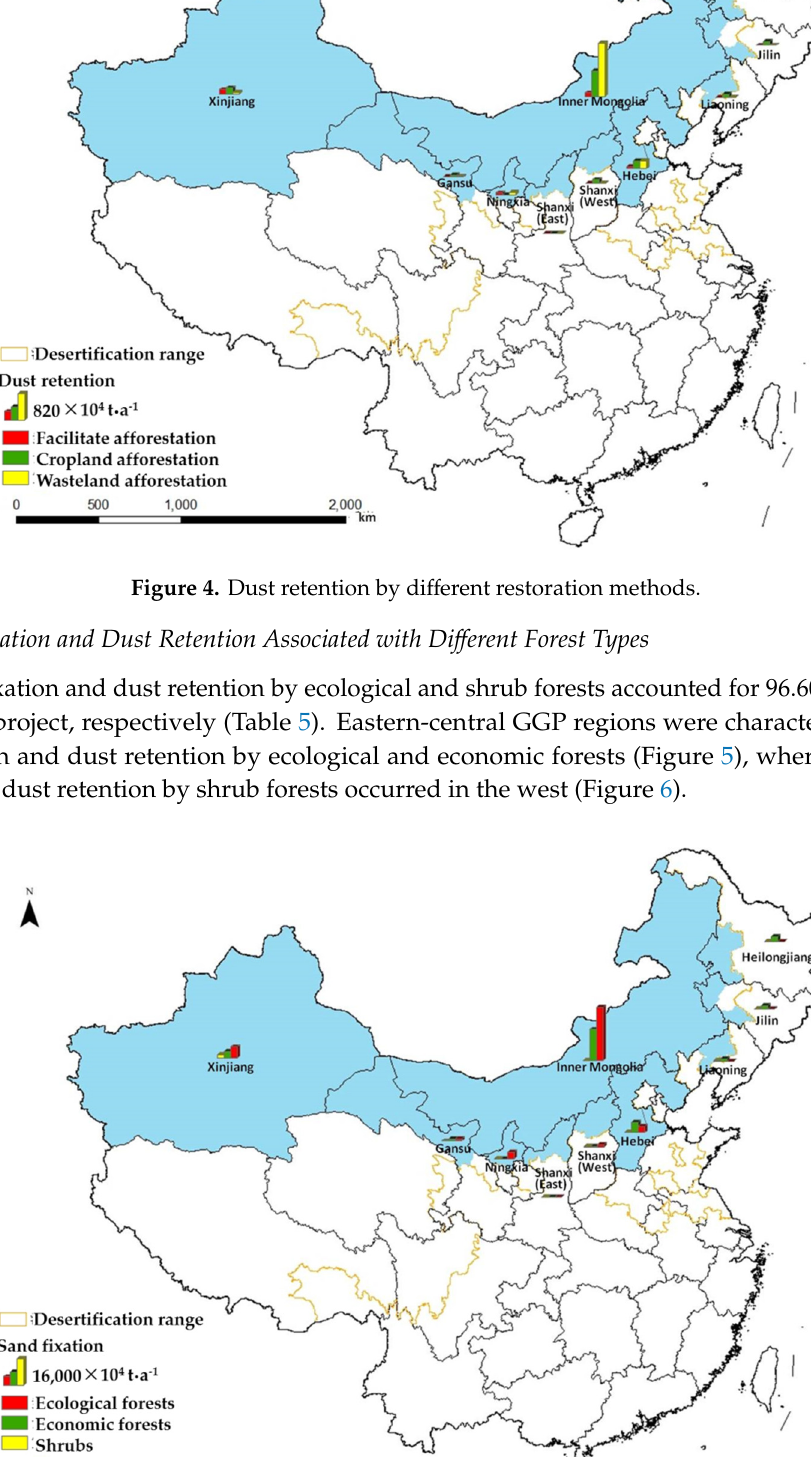
Figure 3. Sand fixation by different restoration methods.